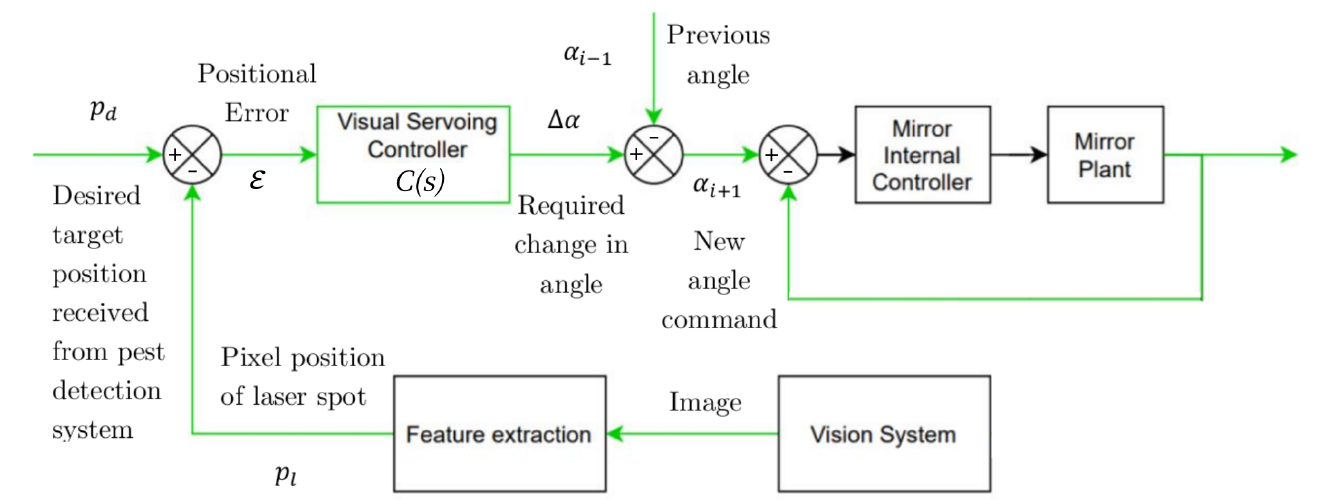
Figure 5. Targeting control scheme embedding visual